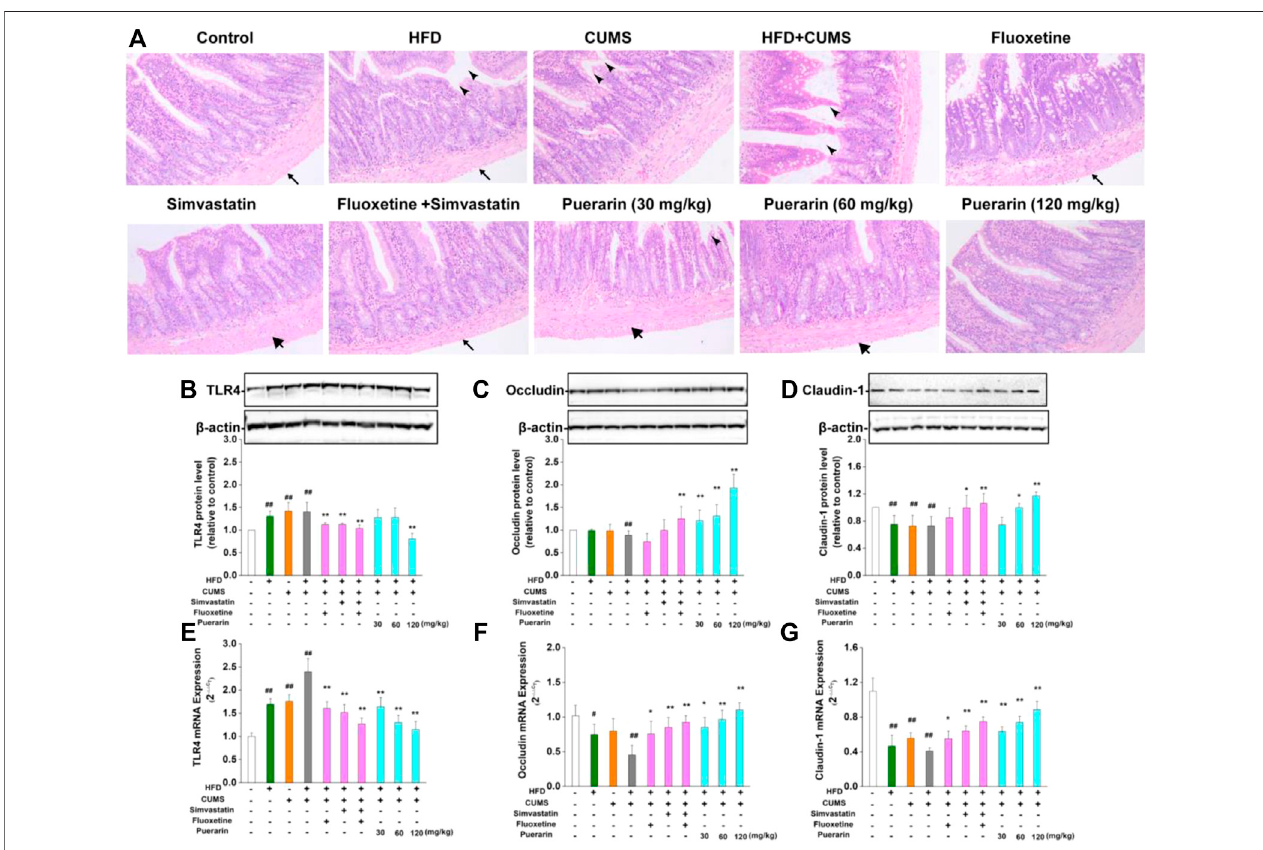
FIGURE 4 | Effect of puerarin on HFD/CUMS-induced small intestine mucosa. (A) Pathological damage of the small intestine was detected by H&E staining. indicates the thickness from the serosa to muscularis; shows that the villi were swollen and broken, and the arrangement of the lamina propria cells was completely disordered; indicates that the serosal layer was loosely arranged or fell off from the muscle layer. The magni fi cation was 100 × . The protein expression of TLR4 (B) , occludin (C) , and claudin-1 (D) was analyzed by Western blotting. β -actin was used as the internal reference. The densitometry was quanti fi ed using ImageJ software. The mRNA levels of TLR4 (E) , occludin (F) , and claudin-1 (G) were detected by real-time RT-PCR. β -actin was used as the housekeeping gene. Values are expressed as mean ± S.E.M ( n (cid:2) 3 for Western blotting and n (cid:2) 4 for real-time RT-PCR). # p < 0.05 and ## p < 0.01 vs. the normal control group; * p < 0.05 and ** p < 0.01 vs. the HFD/CUMS